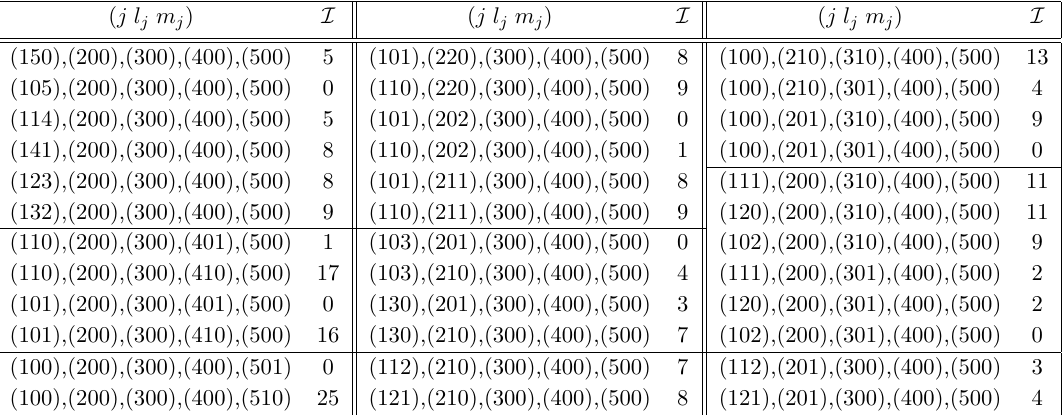
Table 2 . Table for values of I from { j, l j , m j }